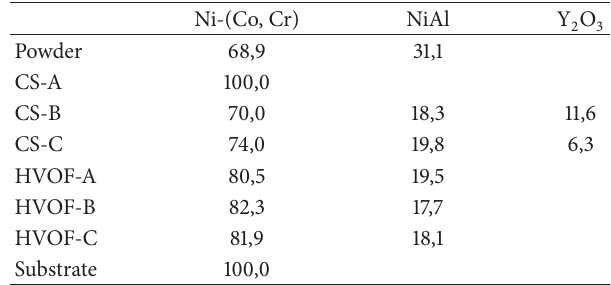
Table 2: Annotation of the samples and optimized EB parameters (set A denotes as-sprayed reference set, i.e., with no electron beam treatment).